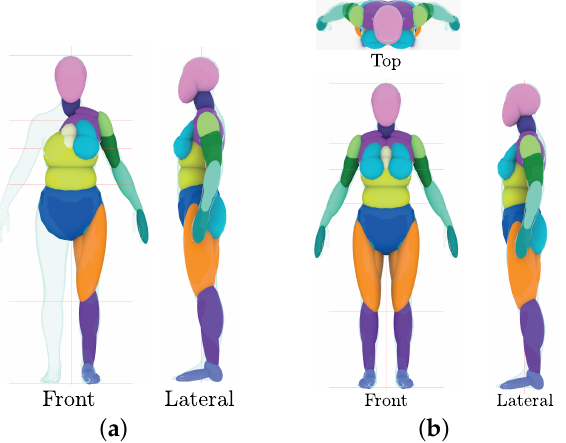
Figure 4. Approximation of the reference 3D model with ellipsoids with resulting Base Mannequin ( BM ) and ellipsoid mannequin and no cushions computed. ( a ) Half of the body approximated. ( b ) The full body approximated and mirroring executed.